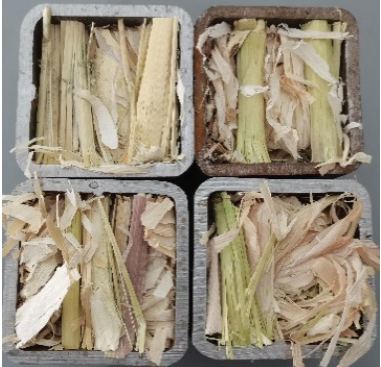
Figure 2. Sample corn bales.